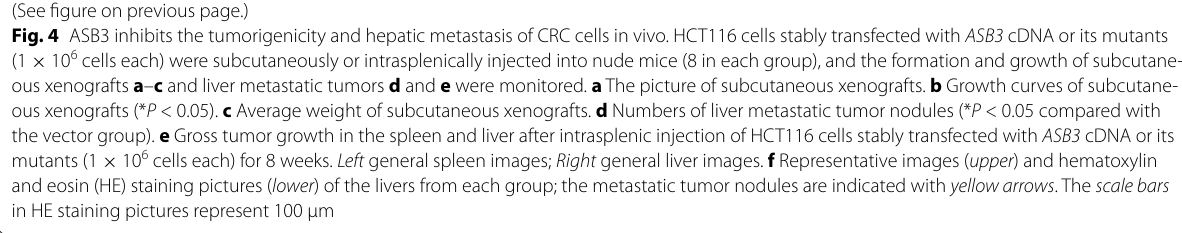
Table 4 The number and percentages of intrasplenic and hepatic tumor formation after intrasplenic injection of HCT116 stable cell lines (1 10 6 cells each) for 8 weeks × Modified HCT116 stable Number of mice Tumor formation a cell line Intrasplenic